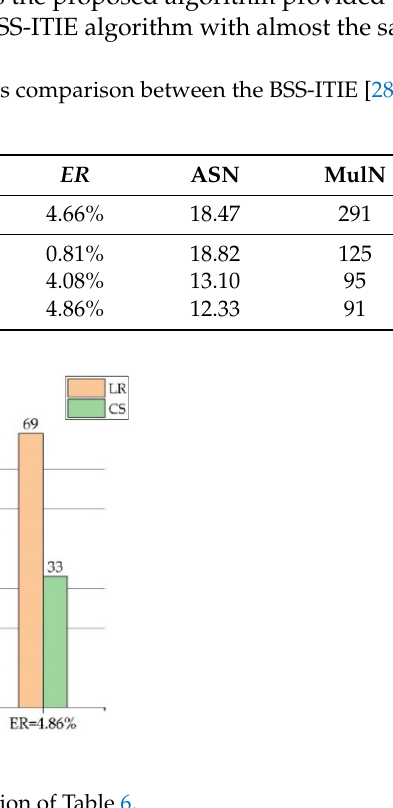
Figure 4. Bar graph representation of Table 4.